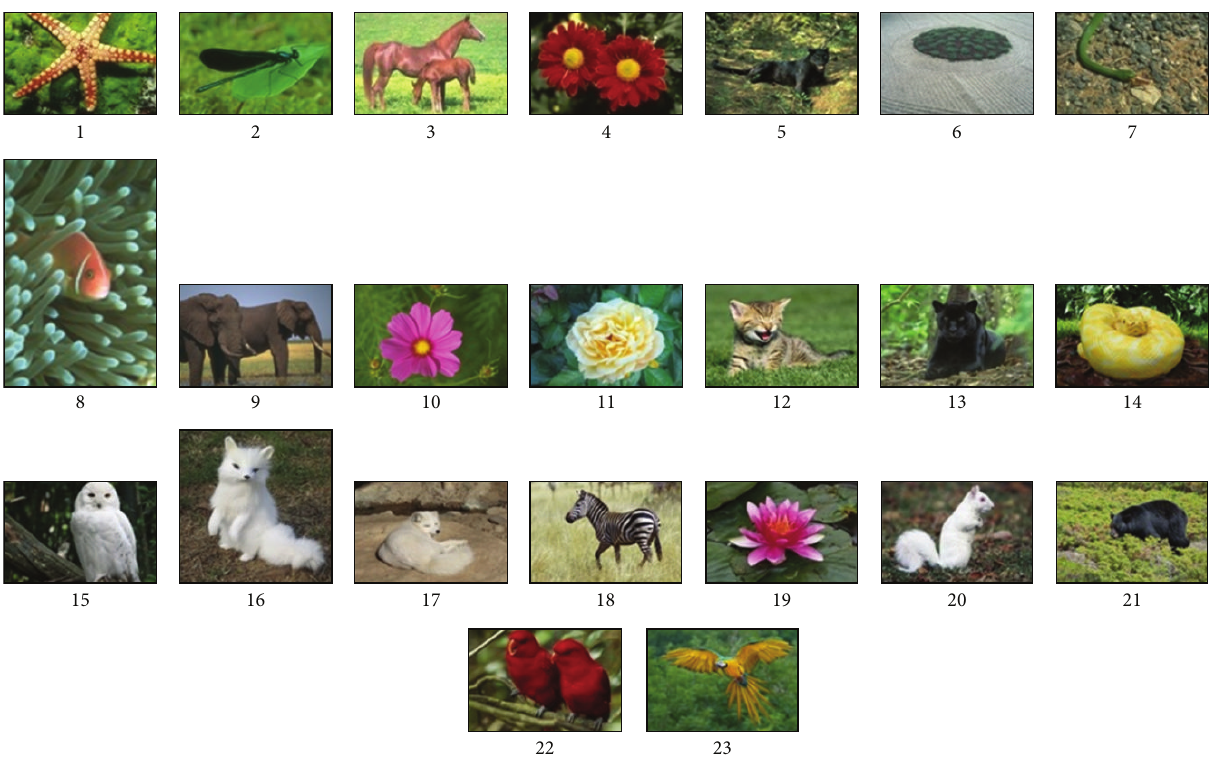
Figure 2: The dataset of